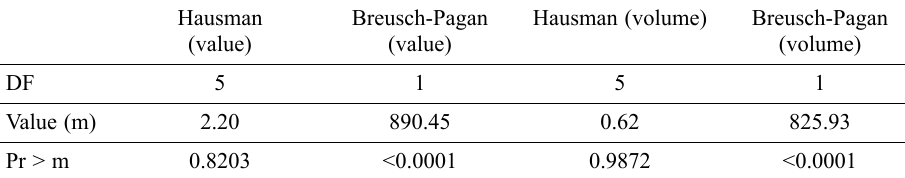
Table 1. Hausman and Breusch-Pagan Tests, value and volume variables